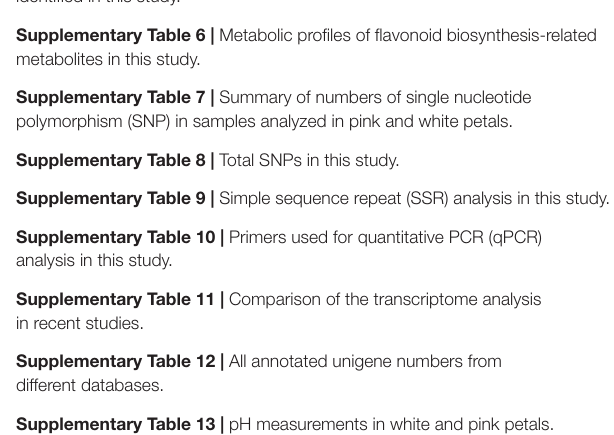
Supplementary Figure 3 | Phylogenetic tree analysis of MYB transcription factors (TFs) in L. sprengeri . Supplementary Figure 4 | Quantitative PCR (qPCR) analysis of MYB TFs in white and pink petals in L. sprengeri . Supplementary Figure 5 | qPCR analysis of genes involved in flavonoid biosynthesis identified in RNA sequencing (RNA-seq). LsUbiquitin (c105178.graph_c0) was used as an internal control. The expression levels of genes in WT plants were set to one. Supplementary Table 1 | Quality control of RNA sequencing (RNA-seq). Supplementary Table 2 | Overview of transcriptome data assembly. Supplementary Table 3 | Data assembly results. Supplementary Table 4 | Kyoto Encyclopedia of Genes and Genomes (KEGG) pathway analysis.